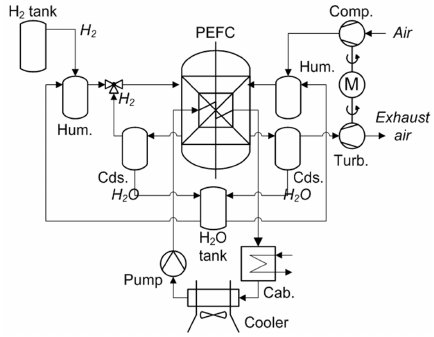
Figure 3. Electricity generation system with low-temperature fuel cells (PEFCs). Hum.: humidifier; Cds.: condensation trap; Cab.: vehicle interior heating; Pump: coolant pump; Comp.: compressor; Cooler: air cooler; PEFC: polymer electrolyte fuel cell; Turb.: turbine.